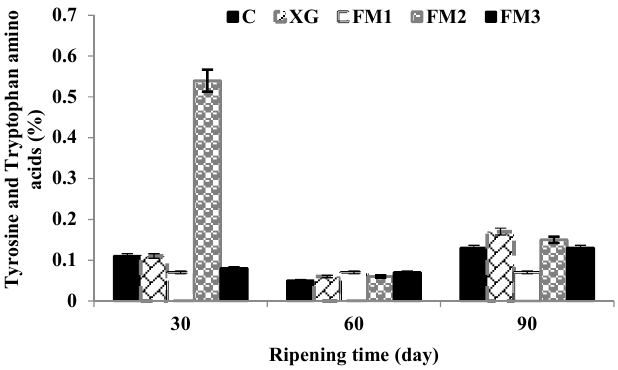
Figure 3. Changes in the amount of free tyrosine and tryptophan amino acids of coated Cheddar cheeses during ripening. C, control, coated with polyvinyl acetate; XG, coated with 0.5% xanthan gum; FM1, FM2, and FM3 coated with 0.75%, 1%, and 1.25% flaxseed mucilage, respectively. Each dot represents the mean of the experimental data with an error bar of three replications.